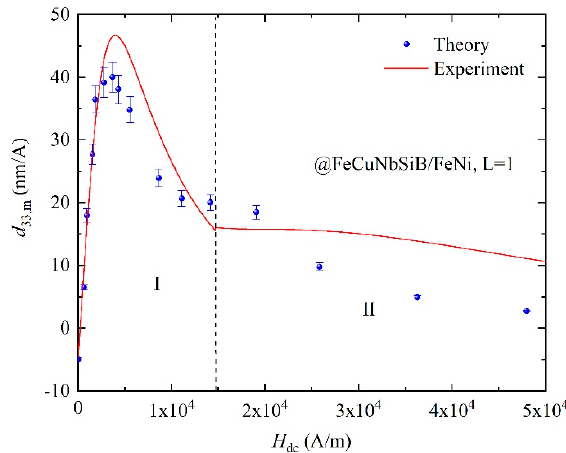
Figure 8. Dynamic piezomagnetic coefficient d 33 ,m of FeCuNbSiB/FeNi as a function of H dc . The layer of FeCuNbSiB is one ( L = 1).